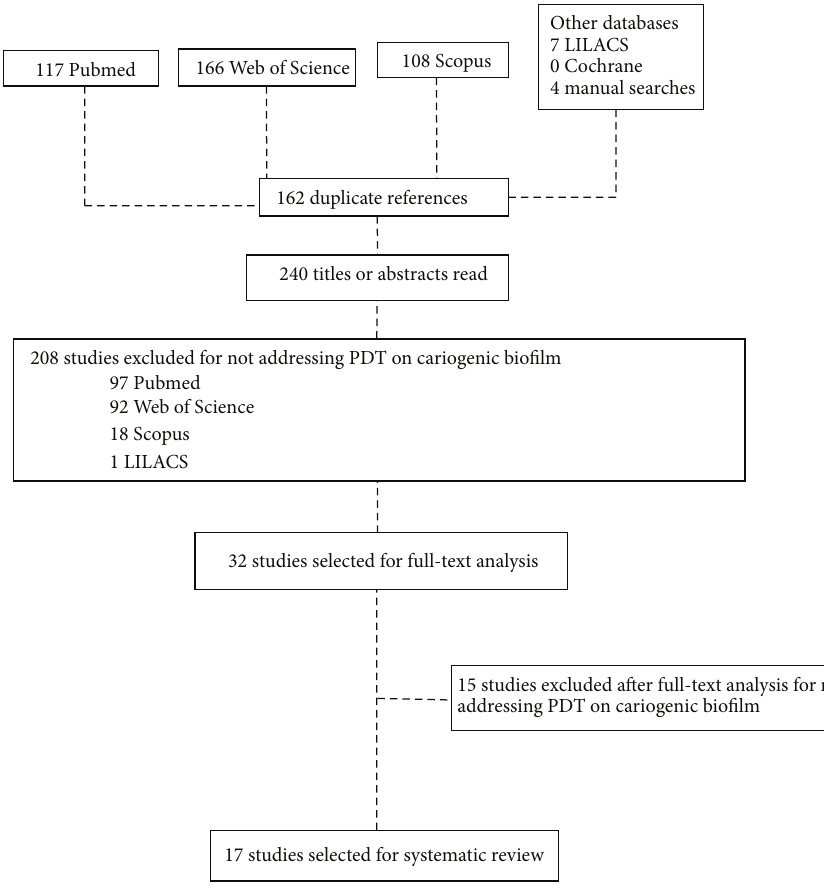
Figure 1: Flowchart demonstrating selection process of studies on PDT and dental